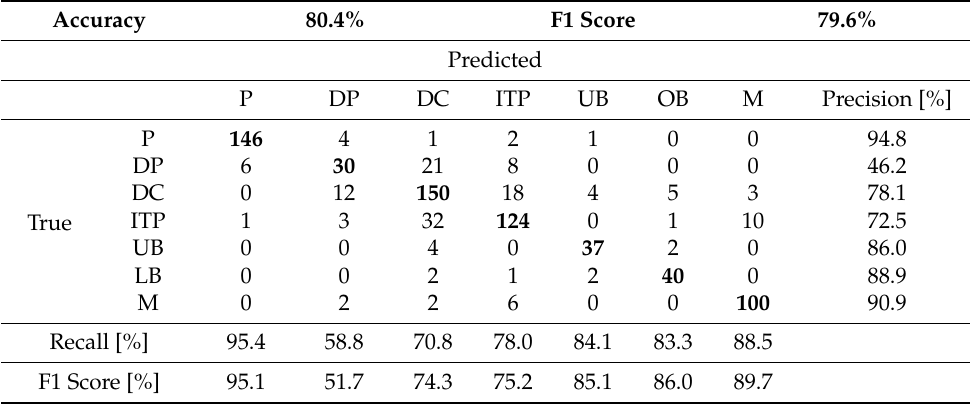
Table 6. Confusion matrix of classification strategy 4